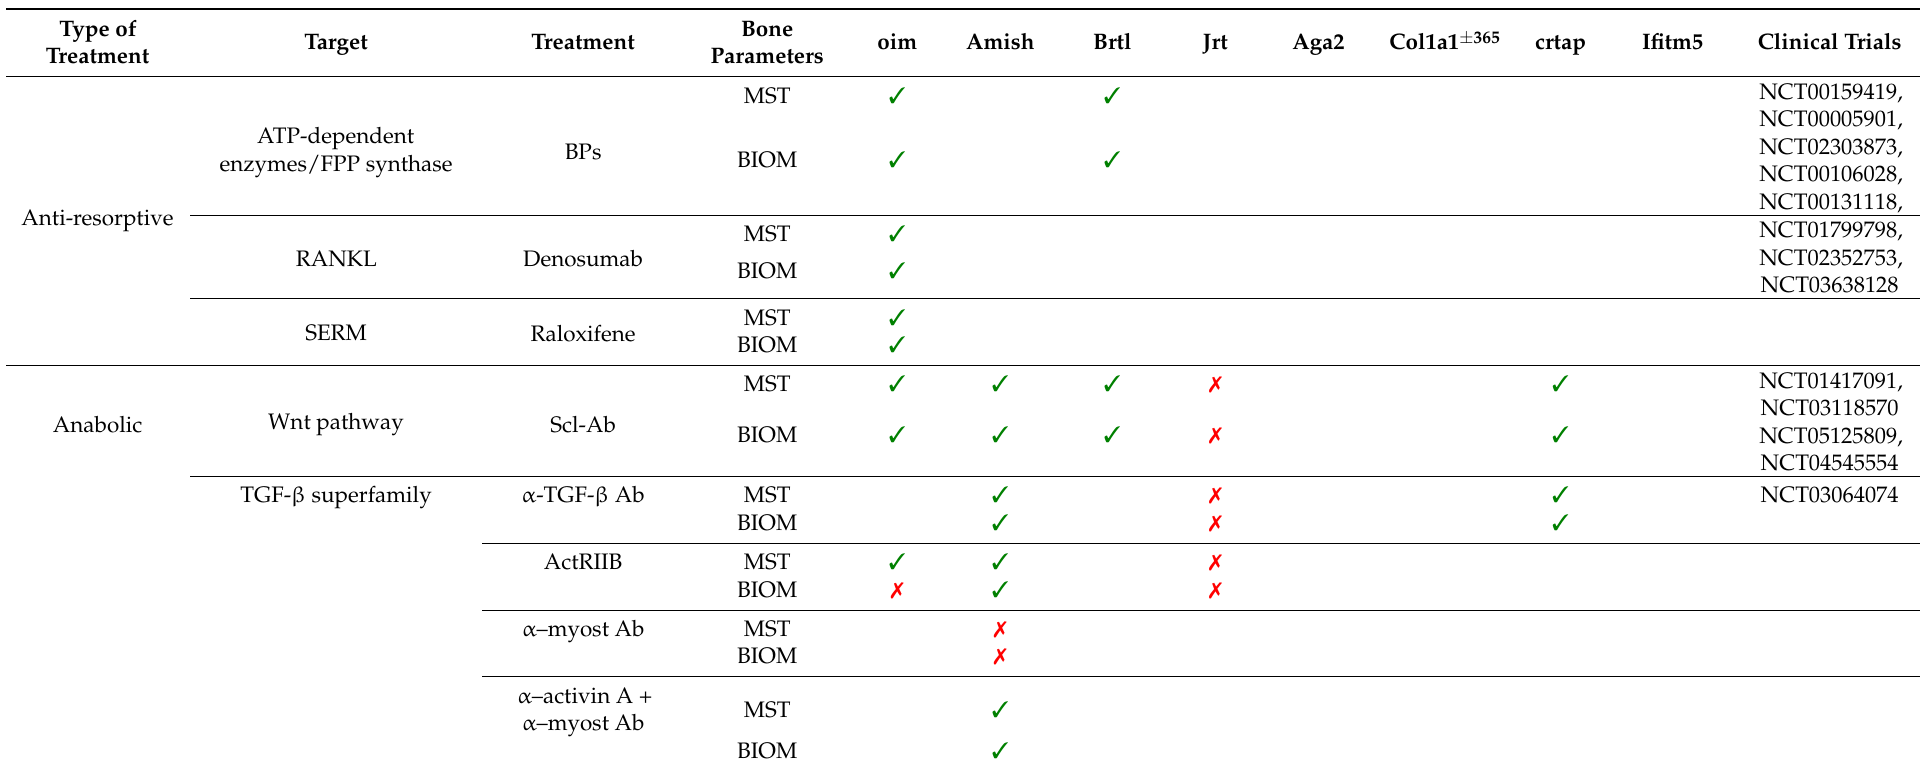
Table 2. Treatments evaluated in preclinical studies with OI murine models. Parameters that were improved ( (cid:51) ) or not ( (cid:55) ) under different therapy attempts in the reported OI murine models are summarized. Moreover, therapies that have been addressed in clinical trials with OI patients are